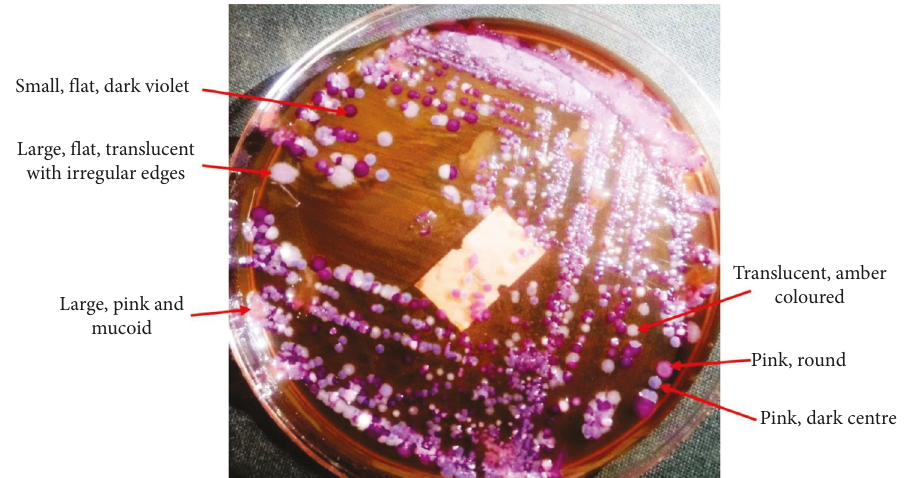
Figure 2: A culture plate showing bacterial carriage in a sample. At least six different colony types can be identified. Table 5: Relationship between bacterial carriage in samples and environmental risk factors. Bacteria carriage (number of colonies) of 3 per sample Odds ratio (95% CI) ≥